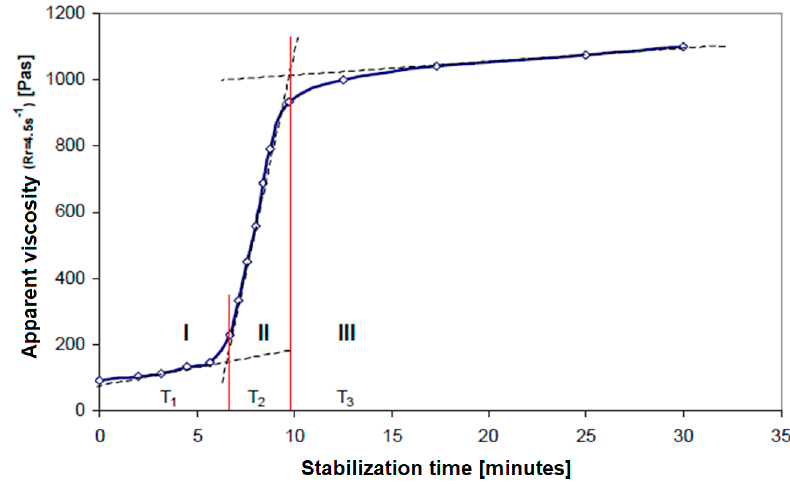
Figure 3. Structure formation in sealing slurries [47,48]. Dashed lines tangent to the course of viscosity changes. The intersection points of these tangents mark the stages of structure formation. The red lines are the projection of the intersection points on the X axis.